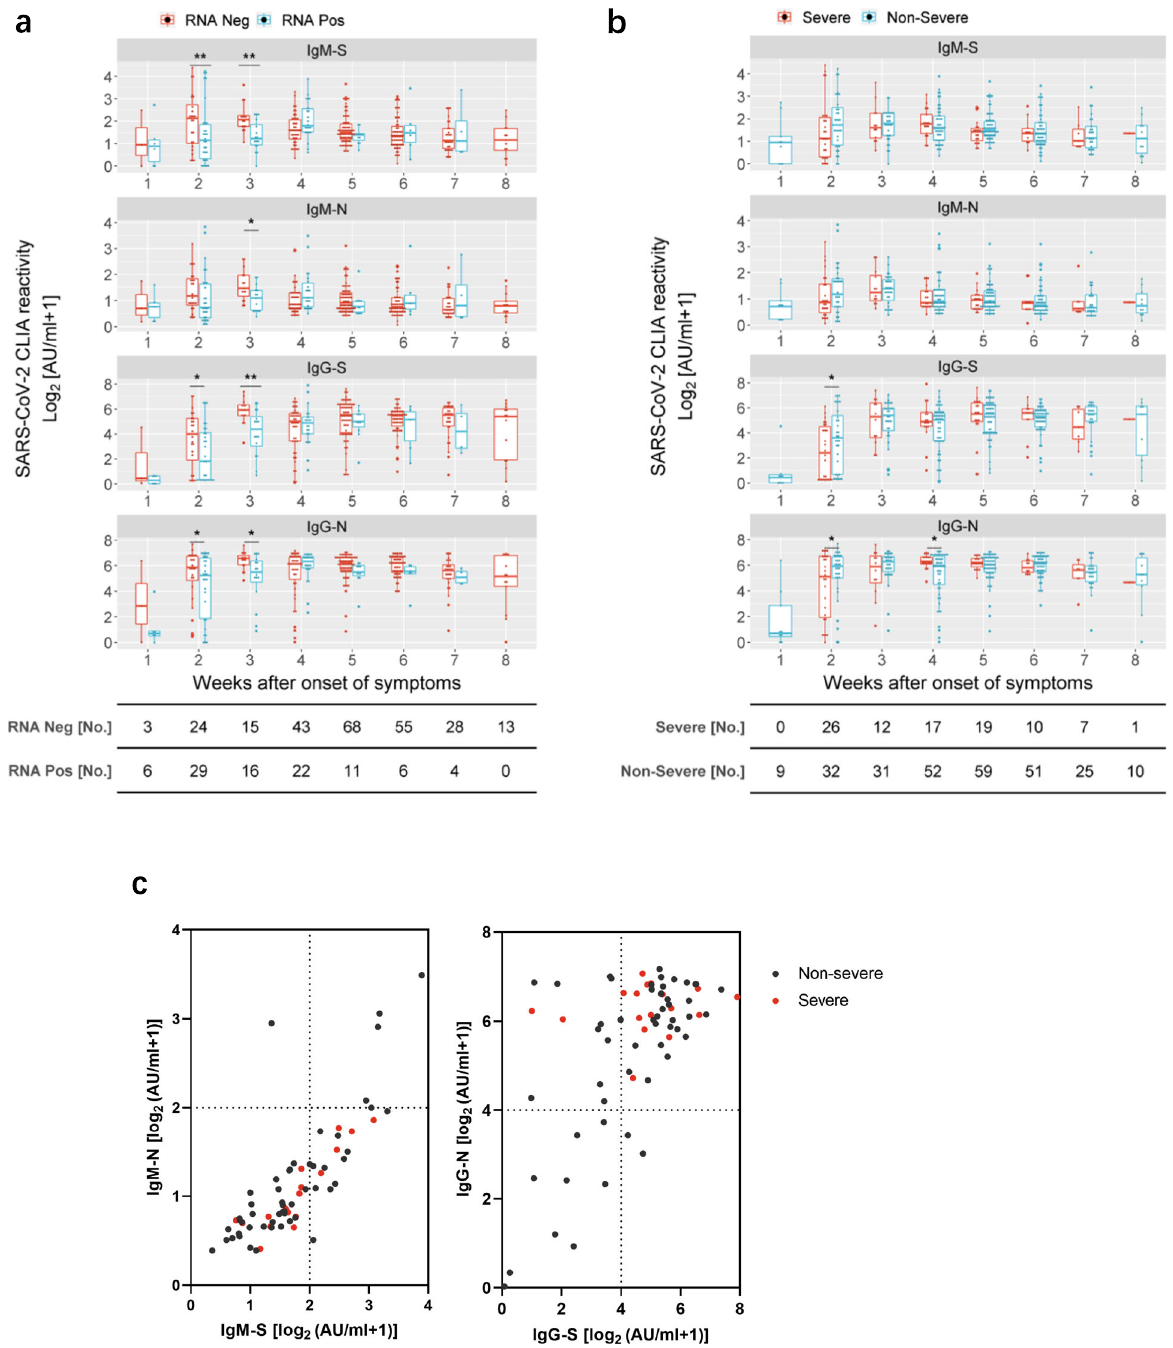
Fig. 2 Correlation of antibody titers with virus control and severity of illness in COVID-19 patients. a S- and N-speci fi c CLIA-reactive IgM/IgG were compared in COVID-19 patients who were virus RNA-negative (red) versus those who were virus RNA-positive (blue) at the time point of sampling at different periods after the disease onset. A total of 343 results were acquired for this analysis. Each antibody detection value is either classi fi ed into the RNA-negative group or the RNA-positive group according to the simultaneous RNA detection result. Adjusted p values are as follows: second week after onset: IgM-S ( p = 0.008); IgG-S ( p = 0.012); IgG-N ( p = 0.042); third week after onset: IgM-S ( p = 0.007); IgM-N ( p = 0.023); IgG-S ( p = 0.005); IgG-N ( p = 0.014). b Comparison of S- and N-speci fi c CLIA-reactive IgM/IgG titers between severe ( n = 60, red) and nonsevere ( n = 149, blue) patients at different periods after the disease onset. Adjusted p values are as follows: second week after onset: IgG-S ( p = 0.028); IgG-N ( p = 0.028); third week after onset: IgG-N ( p = 0.019). The boxes in a and b show medians (middle line), 75% quartiles (upper bound) and 25% quartiles (lower bound), and the whiskers show 1.5× the IQR above and below the box. Repeated measures (mixed model) ANOVA was used for statistical analysis. * p < 0.05; ** p < 0.01; *** p < 0.001, two-sided. The table below the fi gure represents the number of samples at each time point. c Comparison of 64 severe and nonsevere patients (69 samples) at different S- and N-speci fi c CLIA-reactive IgM/IgG levels at the fourth week after symptoms onset.